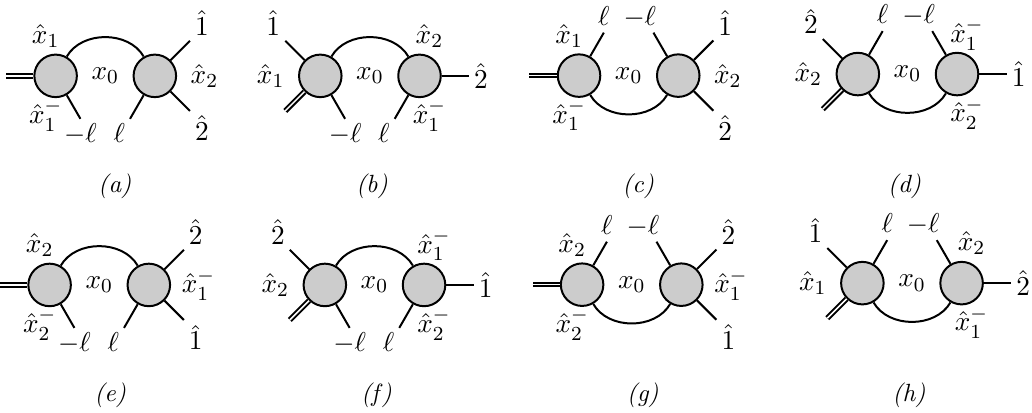
Figure 10. Recombination of single-cut diagrams contributing to the one-loop recursion. The (cid:12)rst line contributes to F (1 ; 2 ; ‘; (cid:0) ‘ ) while the second to F (2 ; 1 ; ‘; (cid:0) ‘ ). Diagrams (a,b,d) and (c) are accompanied by a propagator 1 = ( x + the corresponding propagators are 1 = ( x +